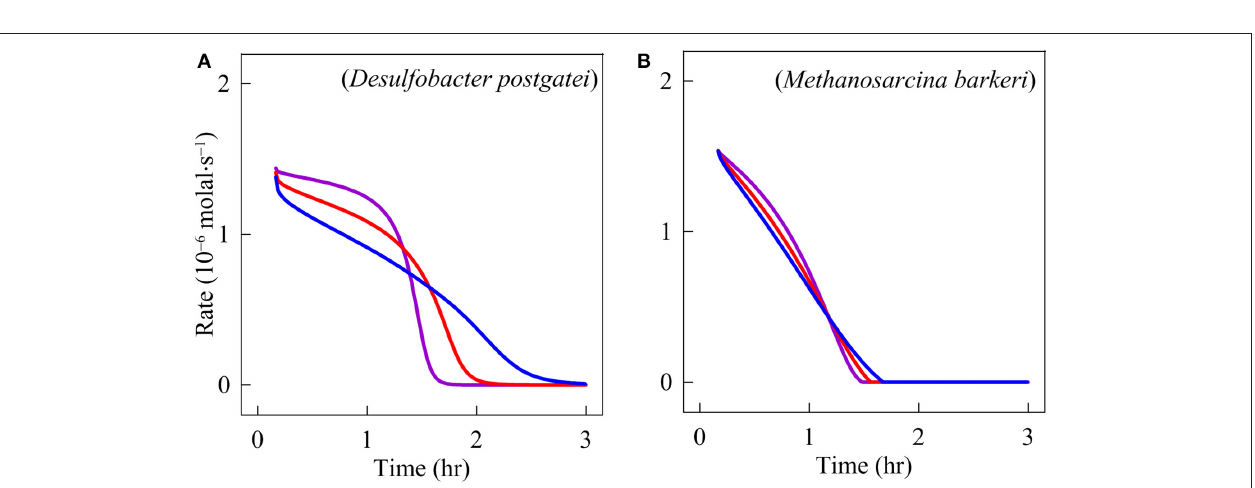
FIGURE 1 | Variation with time in the concentrations of acetate (A) , sulfide (B) , methane (C) , bicarbonate, and sulfate (D) in a batch reactor inoculated with Desulfobacter postgatei and Methanosarcina barkeri . Data points are the experimental results of Schönheit et al. (1982, their figure 3) at pH 7; the lines are the simulation results at pH 7 (blue), 6 (red), and 5 (purple) using microbial rate laws (Equations 3 and 10) and the parameters in Table 1 .